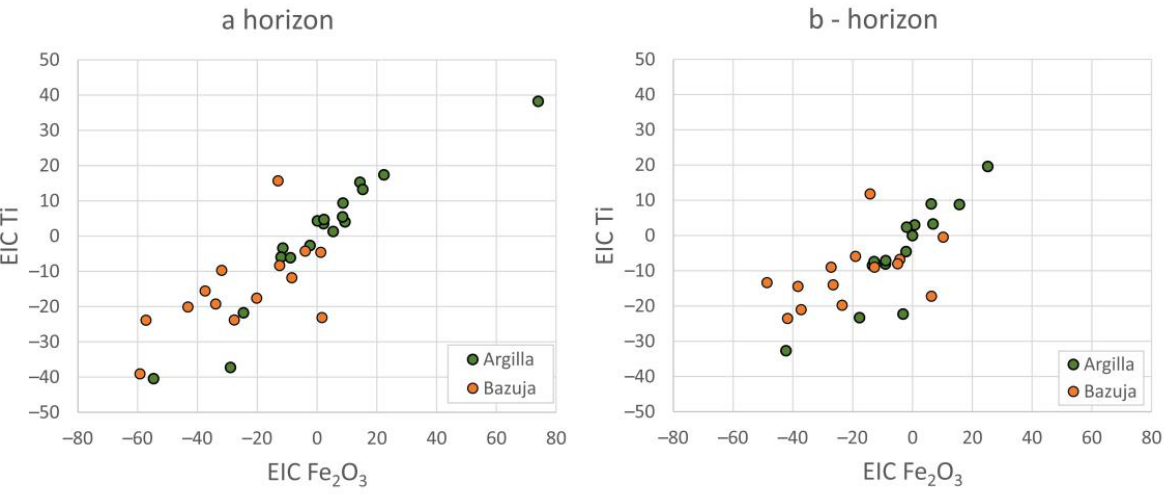
Figure 7. Distribution of calculated EIC Fe 2 O 3 compared to EIC Ti in a and b soil horizons in the rivers Argilla and Bazuja’s catchments.